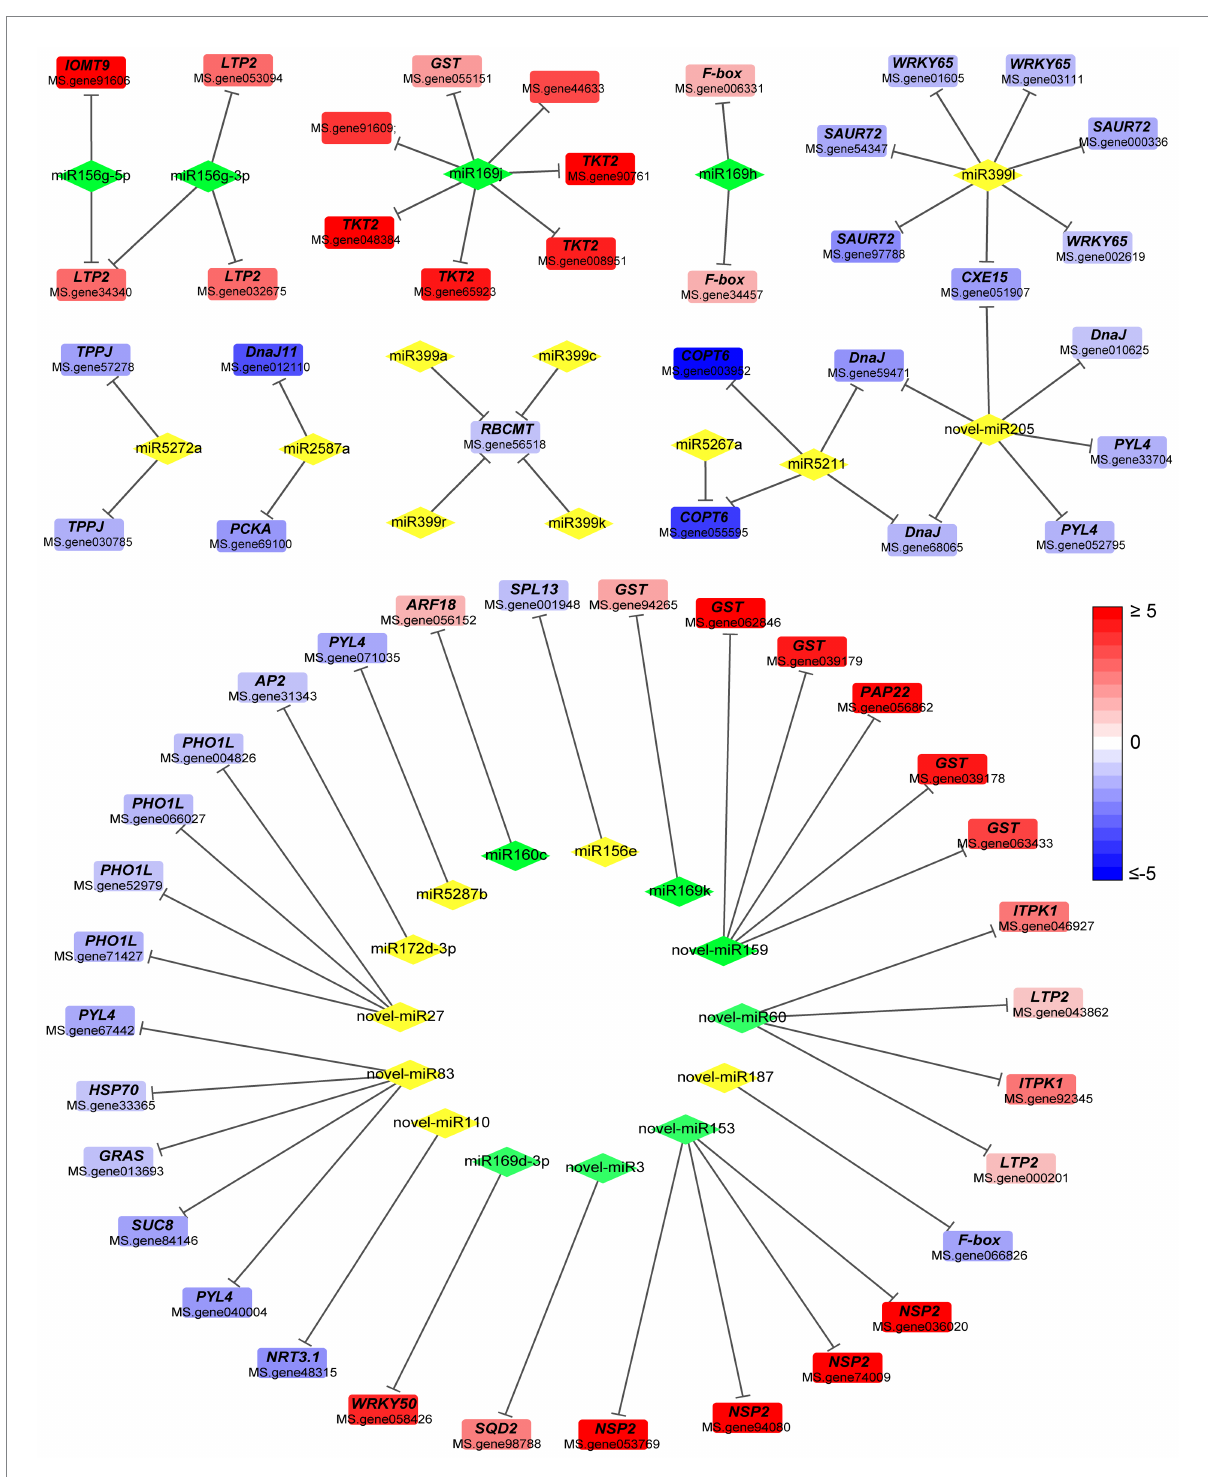
FIGURE 4 Regulatory network of differentially expressed miRNAs and differentially expressed genes. Diamond and square represent miRNA and mRNA, respectively. Green diamond and yellow diamond represent downregulated and upregulated miRNA, respectively. Line represents negatively regulatory relationship between miRNA and its target. Red or blue square indicates increase or decrease in the fold change value. Full red indicates ≥ 2-fold change. Full blue indicates ≤ − 2-fold change. GST , Glutathione S-transferase ; LTP2 , non-specific lipid-transfer protein 2 ; TKT2, probable 1-deoxy-D-xylulose-5-phosphate synthase 2 ; F-box, F-box protein ; IOMT9, isoflavone-7-O-methyltransferase 9 ; SAUR72, auxin-responsive protein SAUR72 ; WRKY65, WRKY transcription factor 65 ; CEX15, carboxylesterase 15 ; DnaJ, chaperone DnaJ-like protein ; TPPJ, trehalose- phosphate phosphatase J ; PCKA, phosphoenolpyruvate carboxykinase ( ATP ); RBCMT, ribulose-1,5 bisphosphate carboxylase/oxygenase ; COPT6, copper transporter 6 ; PYL4, abscisic acid receptor PYL4 ; SPL13, squamosa promoter-binding-like protein 13A ; ARF18, auxin response factor